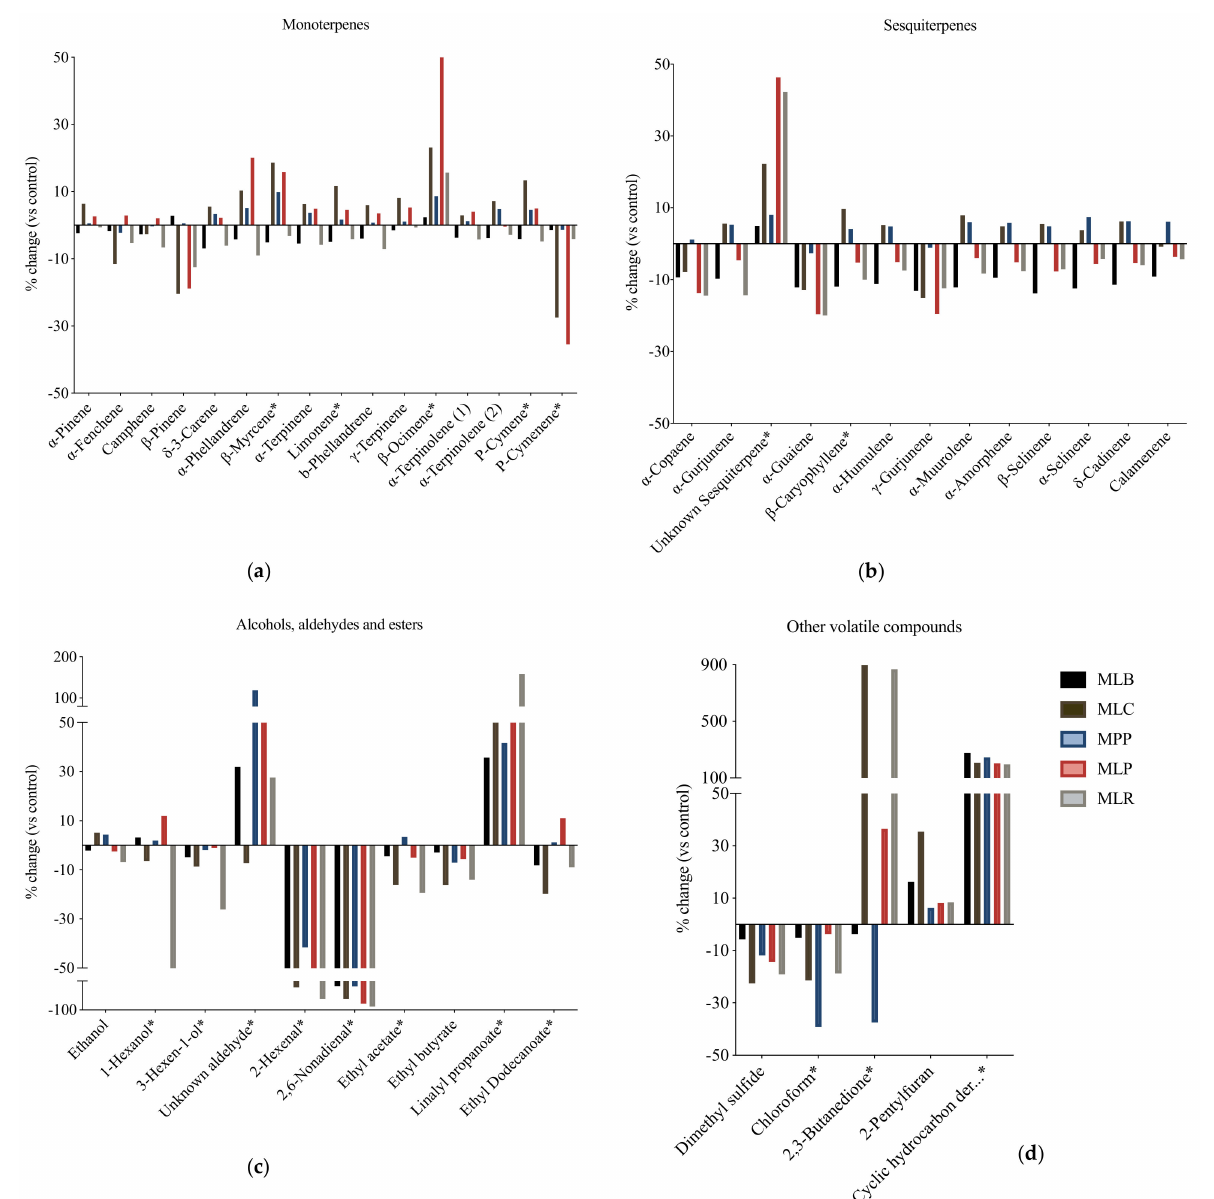
Figure 1. Percentage change of volatile compounds (ng/mL of 2-octanol equivalents). Mango juice fermented with MLB— Levilactobacillus brevis ; MLC— Lacticaseibacillus casei ; MLP— Lactiplantibacillus plantarum subsp. plantarum ; MLR— Lacticaseibacillus rhamnosus ; MPP— Pediococcus pentosaceus . Con- trol is mango juice with no lactic acid bacteria under the same conditions of fermentation (24 h). * Significant difference ( p < 0.05). ( a ) Monoterpenes; ( b ) Sesquiterpenes; ( c ) Alcohols, aldehydes, and esters; ( d ) Other volatile